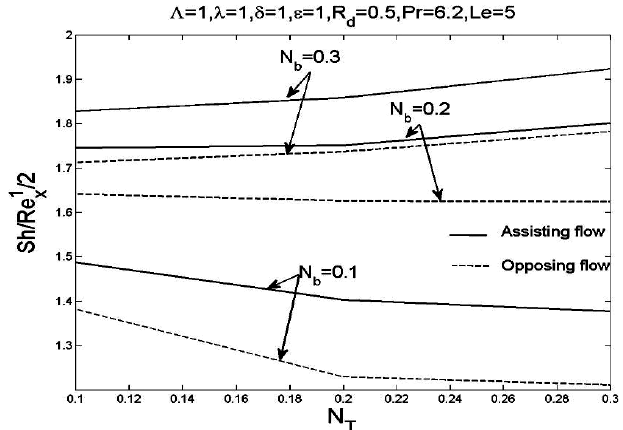
Fig. 29. The effect of the thermophoresis parameter Nt and the Brownian motion parameter Nb on the local Sherwood